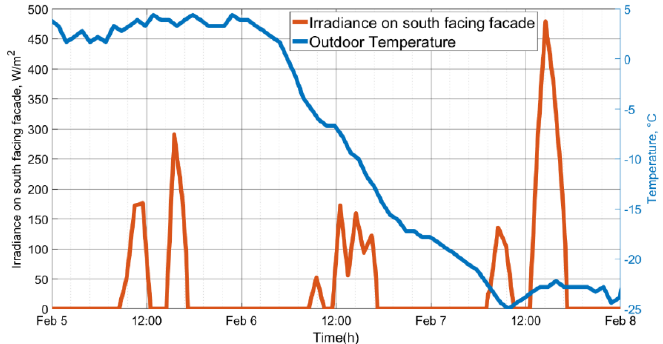
Figure 8. Outdoor temperature and solar flux-Montreal’s coldest days.